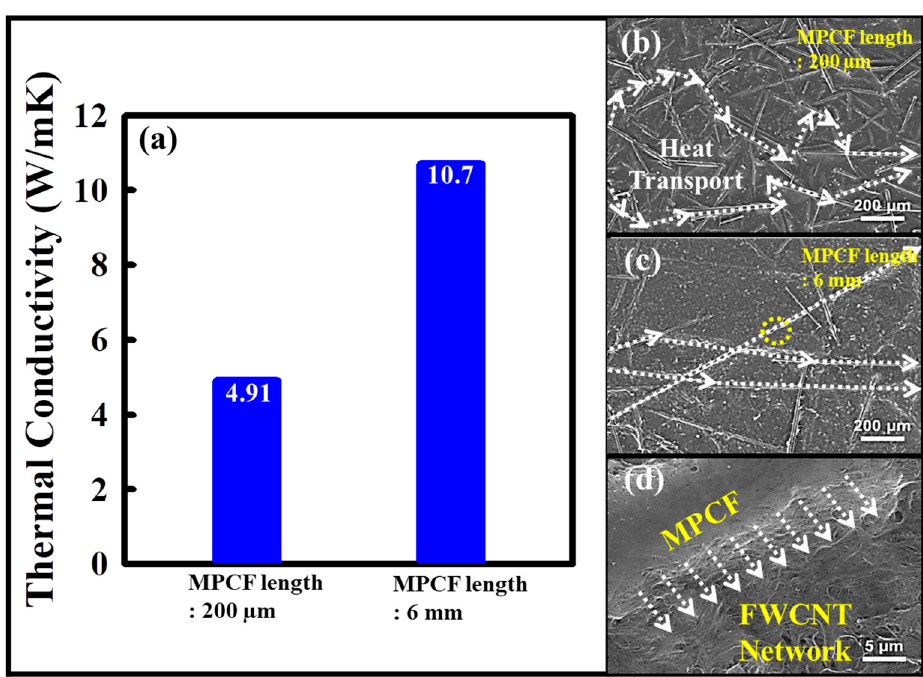
Figure 6. ( a ) Thermal conductivity and ( b – d ) HR-SEM images of FWCNT-MPCF hybrid films with di ff erent MPCF lengths of 200 µ m and 6 mm (MPCF content: 60 wt %; ultrasonication for 0.5 h). ( d ) is high-resolution HR-SEM image of yellow circle in ( c ). The white arrows in ( b – d ) indicate the heat transfer pathways in carbon-based hybrid films.